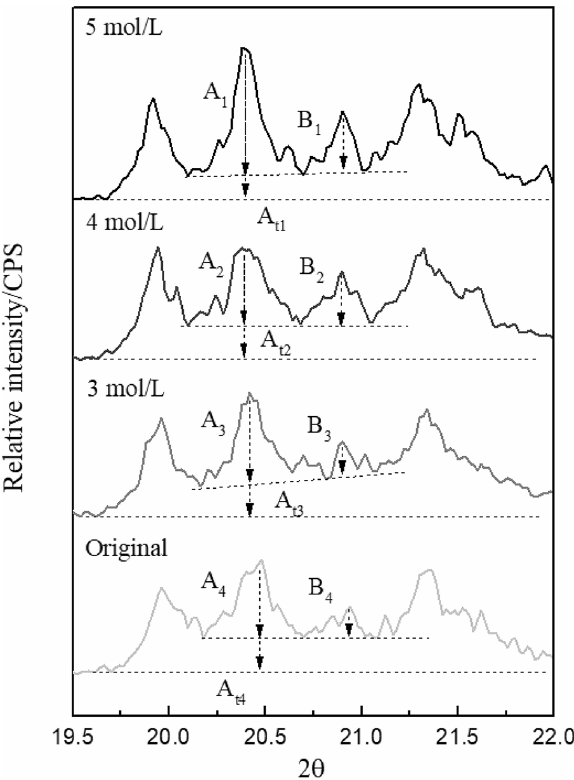
Figure 7. Calculation of crystallinity indices of kaolinite.